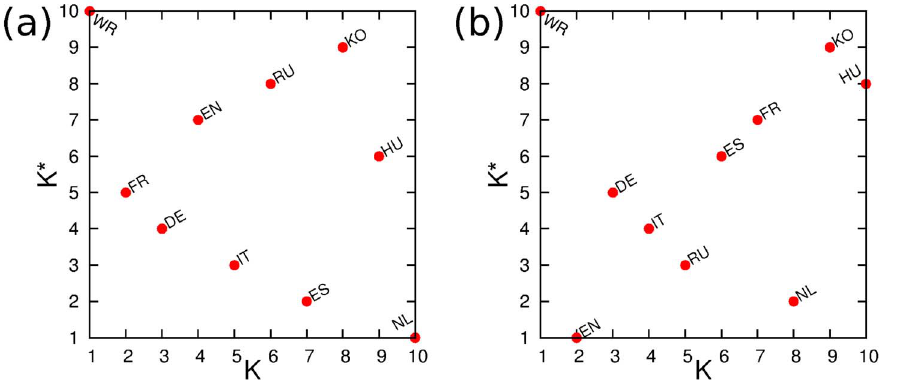
Figure 8. PageRank versus CheiRank plane of cultures with corresponding indexes K and K (cid:2) obtained from the network of cultures for corresponding panels ( a ),( b )